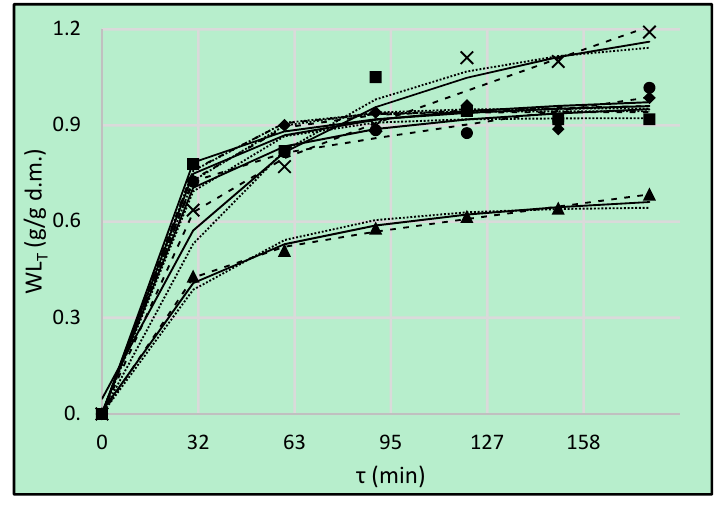
Figure 4. True water loss ( WL T ), kinetics using different solutions: erythritol ( ), xylitol ( ● ), maltitol ( ▲ ), dihydroxyacetone ( ♦ ), sucrose ( × ). Lines are the Peleg’s model (solid lines), the Kelvin–Voigt model (dotted lines) and Burgers Model (dashed lines). Table 7. The influence of osmotic agents and pre-treatment time on true water loss during OD. Factor p -Value Contrast +/ − Limits